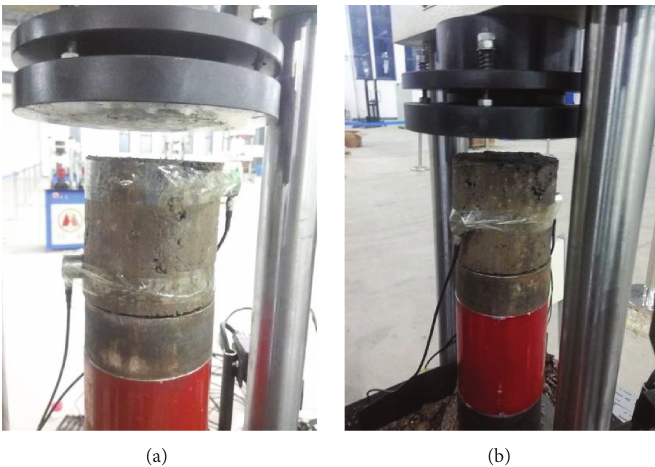
Figure 4: Schemes for sensor layouts: (a) sensors fixed in the middle of specimen and (b) sensors fixed on the end of